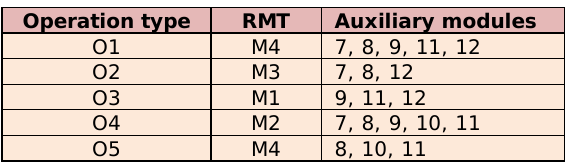
Table 2. Resources required by each operation type